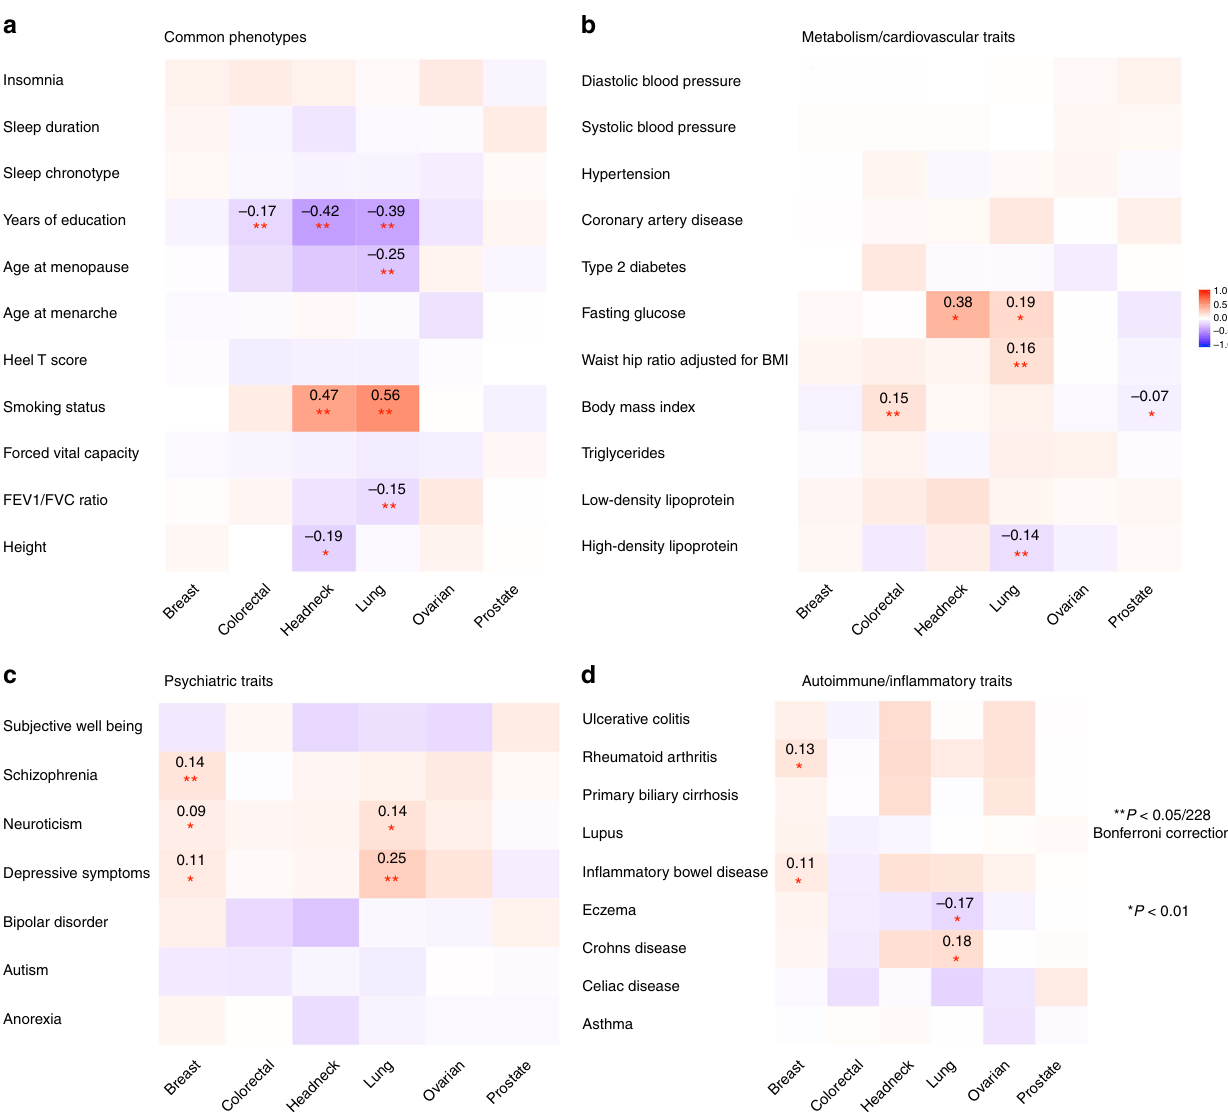
Fig. 3 Cross-trait genetic correlation ( r g ) analysis between cancers and non-cancer traits. The traits were divided into four categories: a Common phenotypes, b Metabolic or cardiovascular related traits, c Psychiatric traits, d Autoimmune in fl ammatory diseases. Pair-wise genetic correlations withstood Bonferroni corrections (228 tests) are marked with double asterisk (**), with estimates of correlation shown in the cells. Pair-wise genetic correlations with signi fi cance at p < 0.01 are marked with a single asterisk (*). The color of cells represents the magnitude of